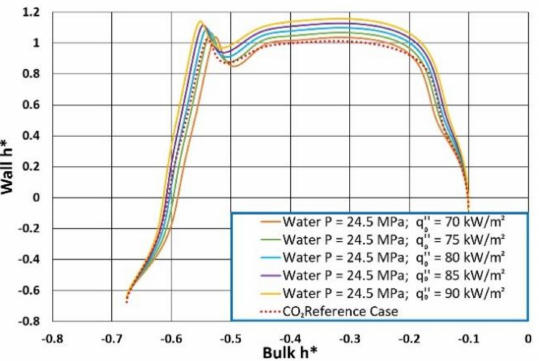
Figure 14. Wall h* trends for water at 24.50 MPa for a reference case with CO 2 , q 0 (cid:48)(cid:48) = 20 kW/m 2 and T in = 24 ◦ C.